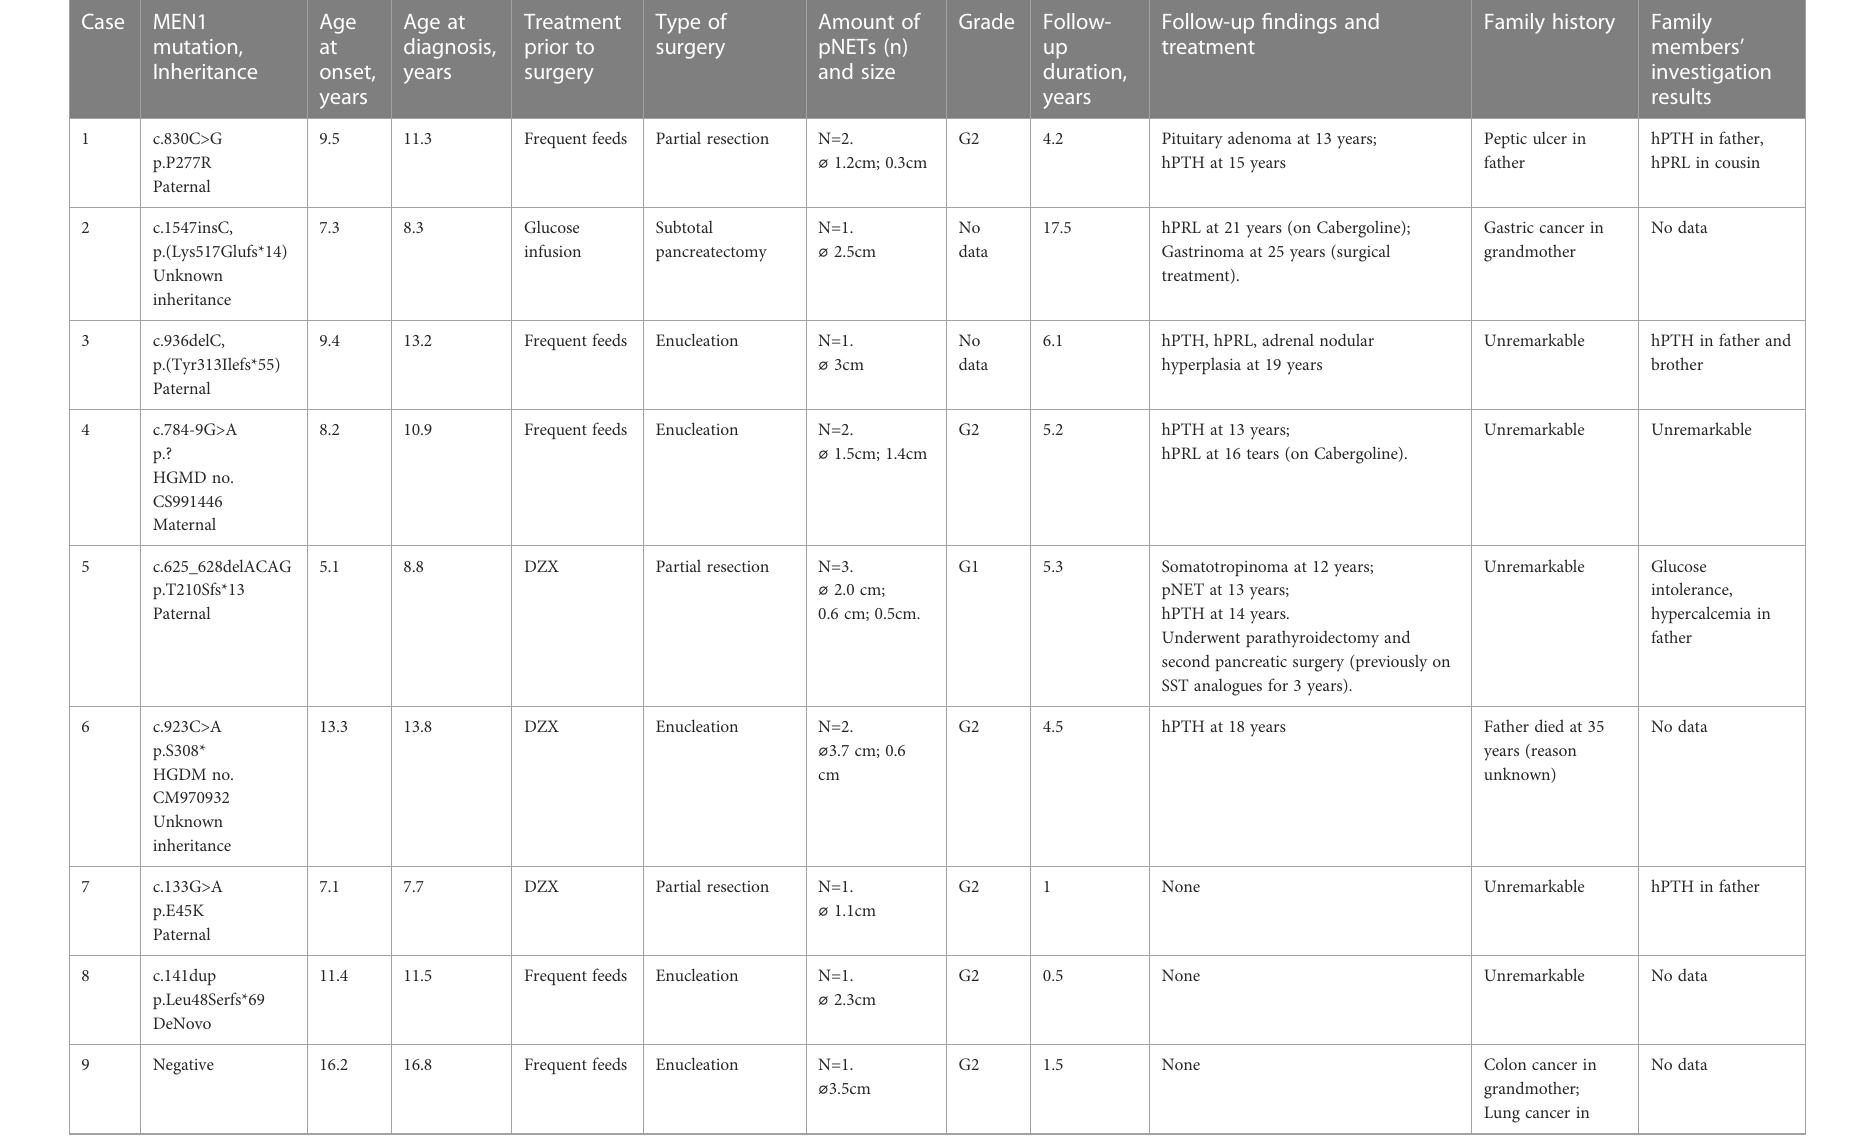
TABLE 2 Comprehensive clinical data on 22 pediatric patients with insulinoma and their family